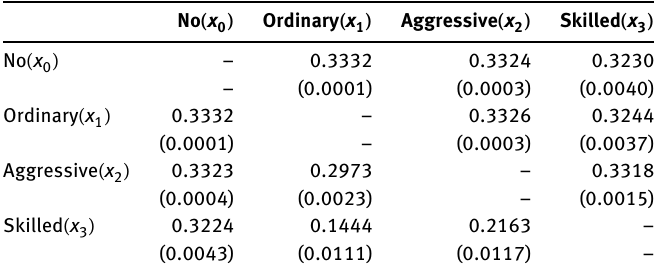
Table 4: Lower bounds on the